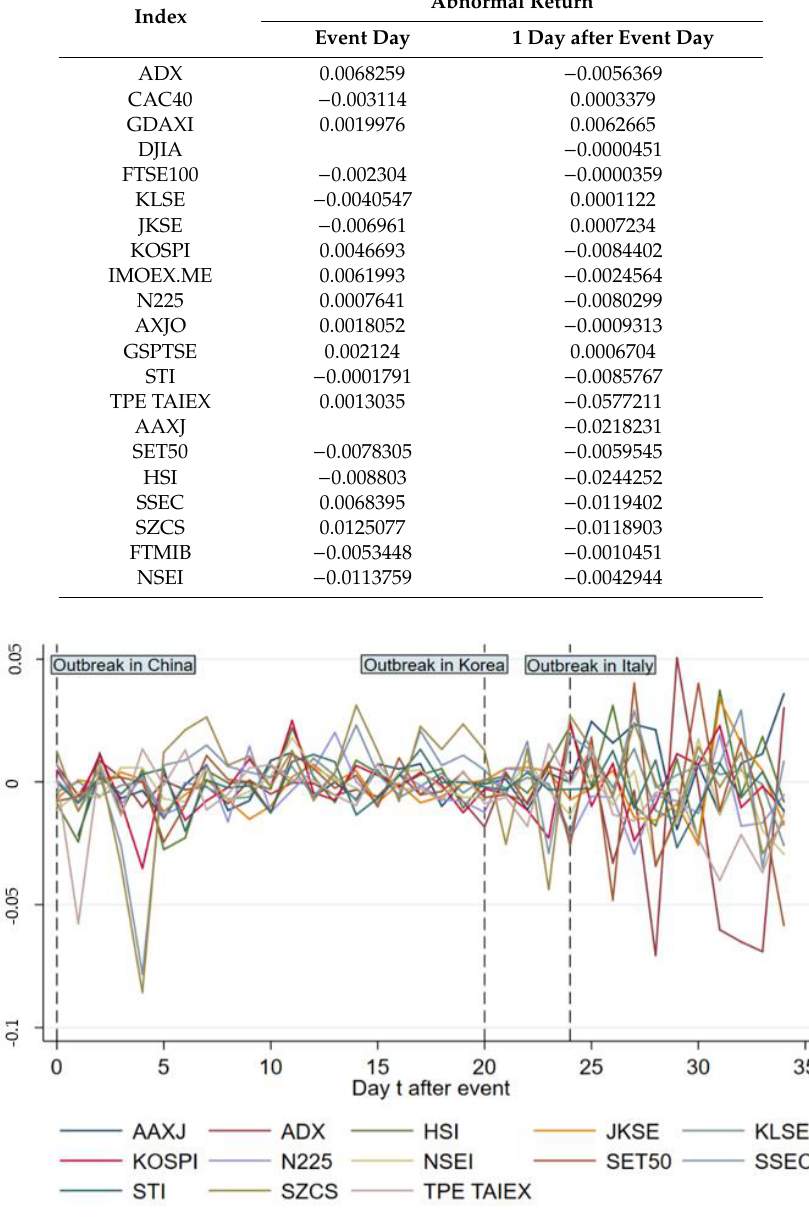
Figure 2. Abnormal Return (AR) change of main indices in Asia from day 0 to 34.